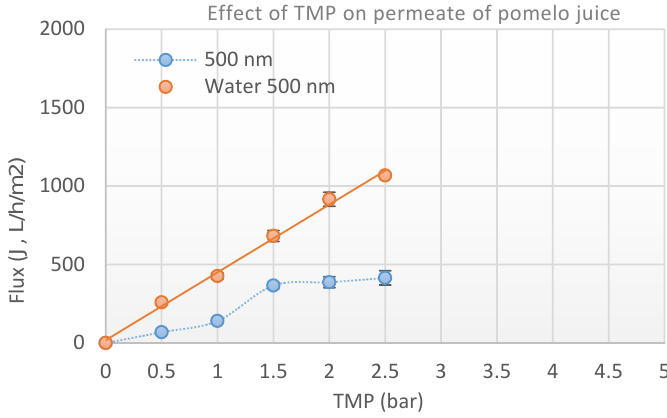
Figure 8. Effect of TMP on permeate flux of pomelo juice ( T = 30 °C; membrane = 500 nm).